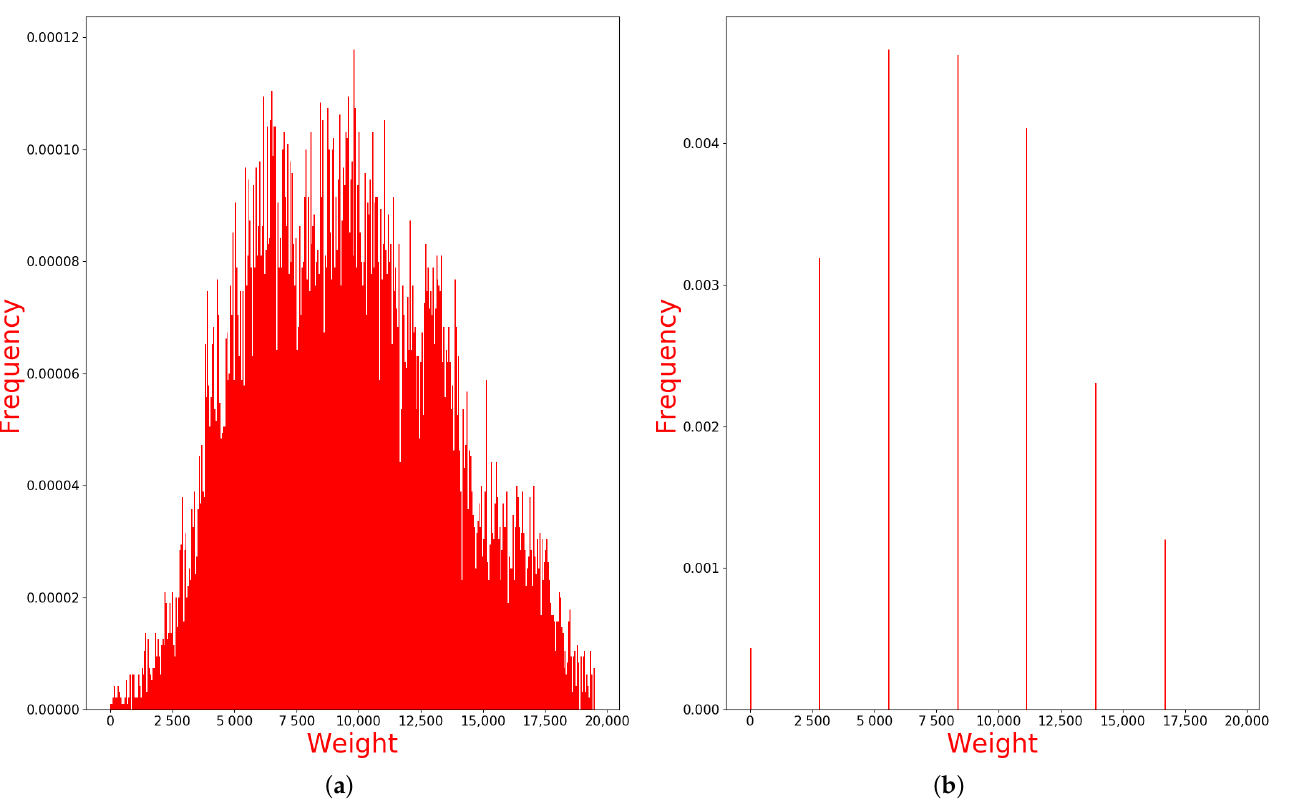
Figure 4. Histogram of weight value ( a ) and Division into seven ranks ( b